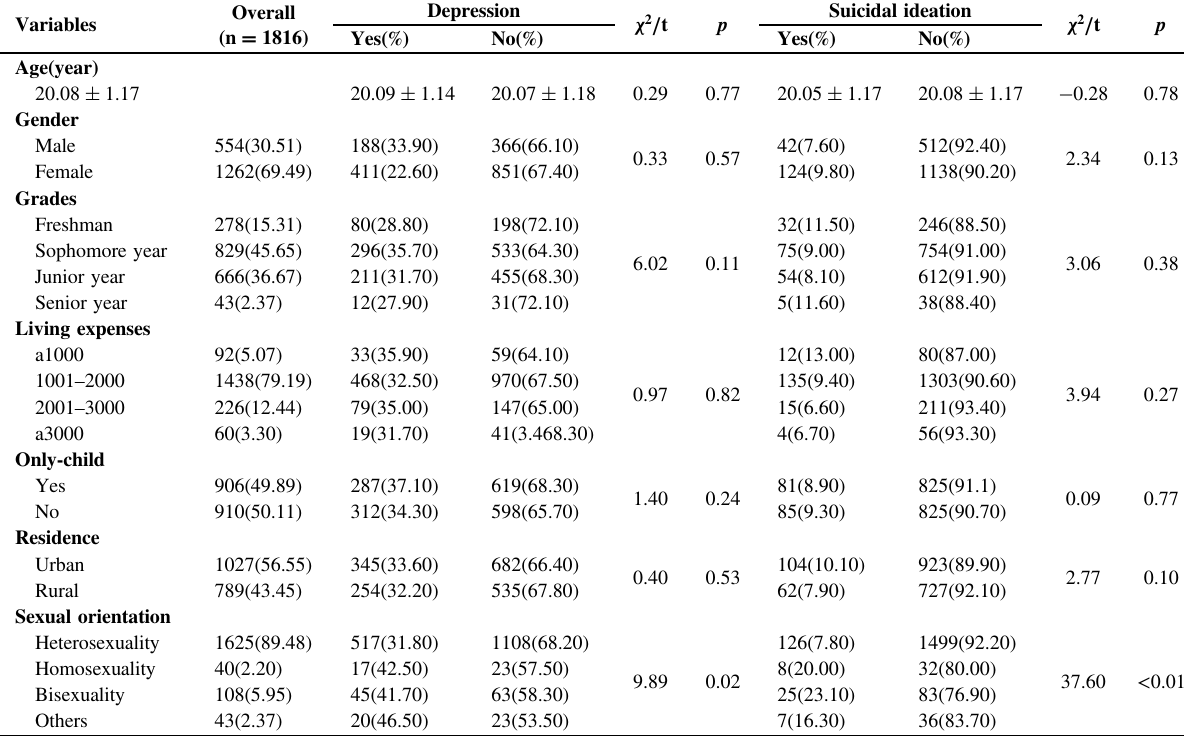
Table 1 Basic characteristics of the participants (n = 1816) Variables